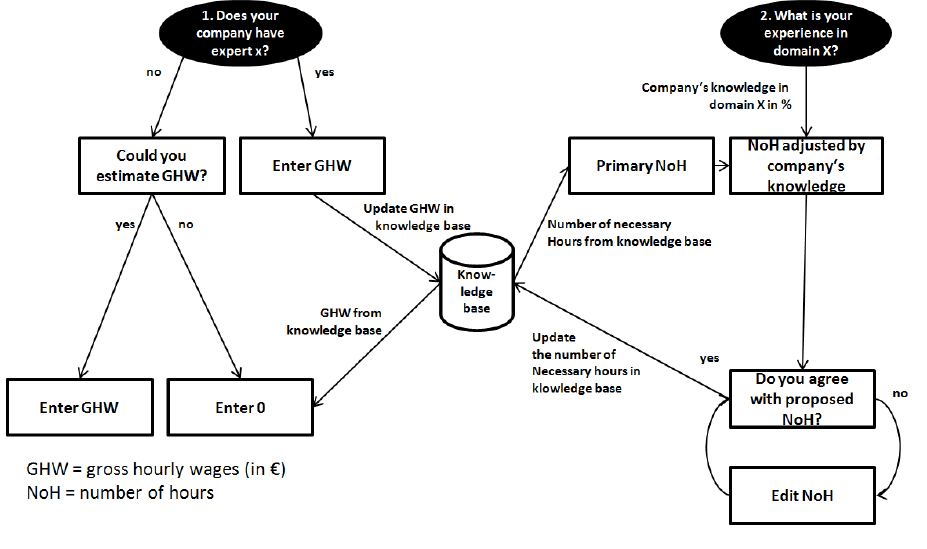
Figure 3 – The main principle of proposed supporting